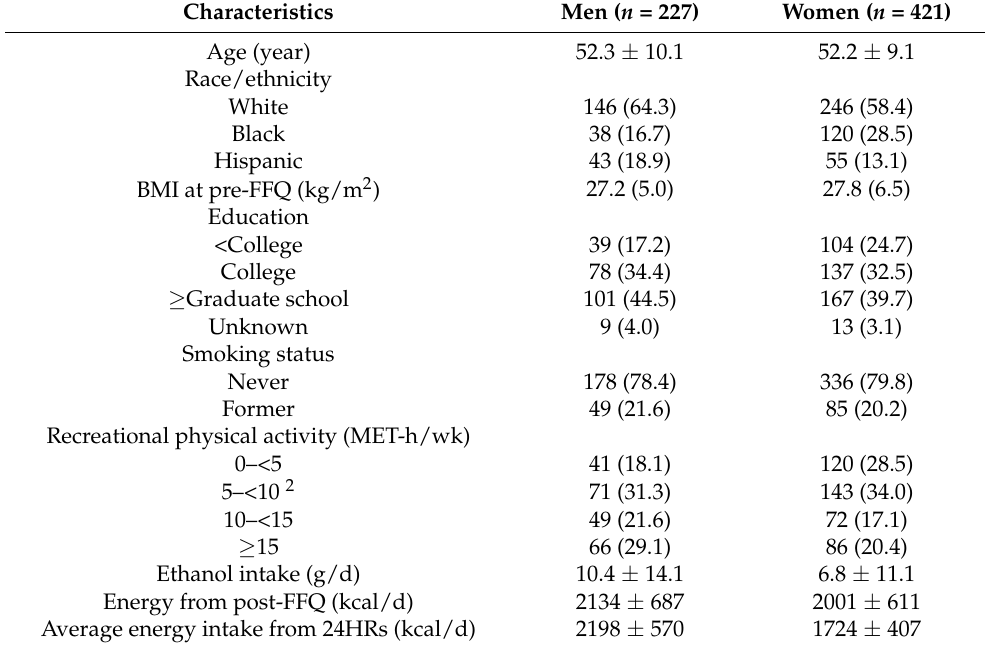
Table 1. Characteristics of participants ( n = 648) in the Cancer Prevention Study-3 Diet Assessment Sub-study 1